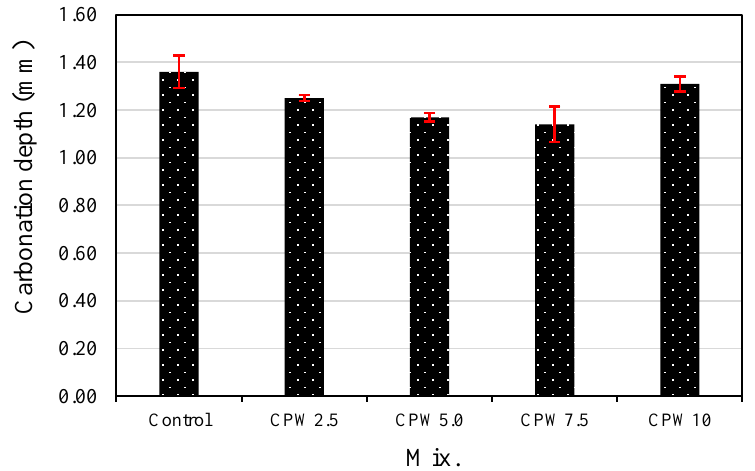
Figure 11. Accelerated carbonation depth of the samples.